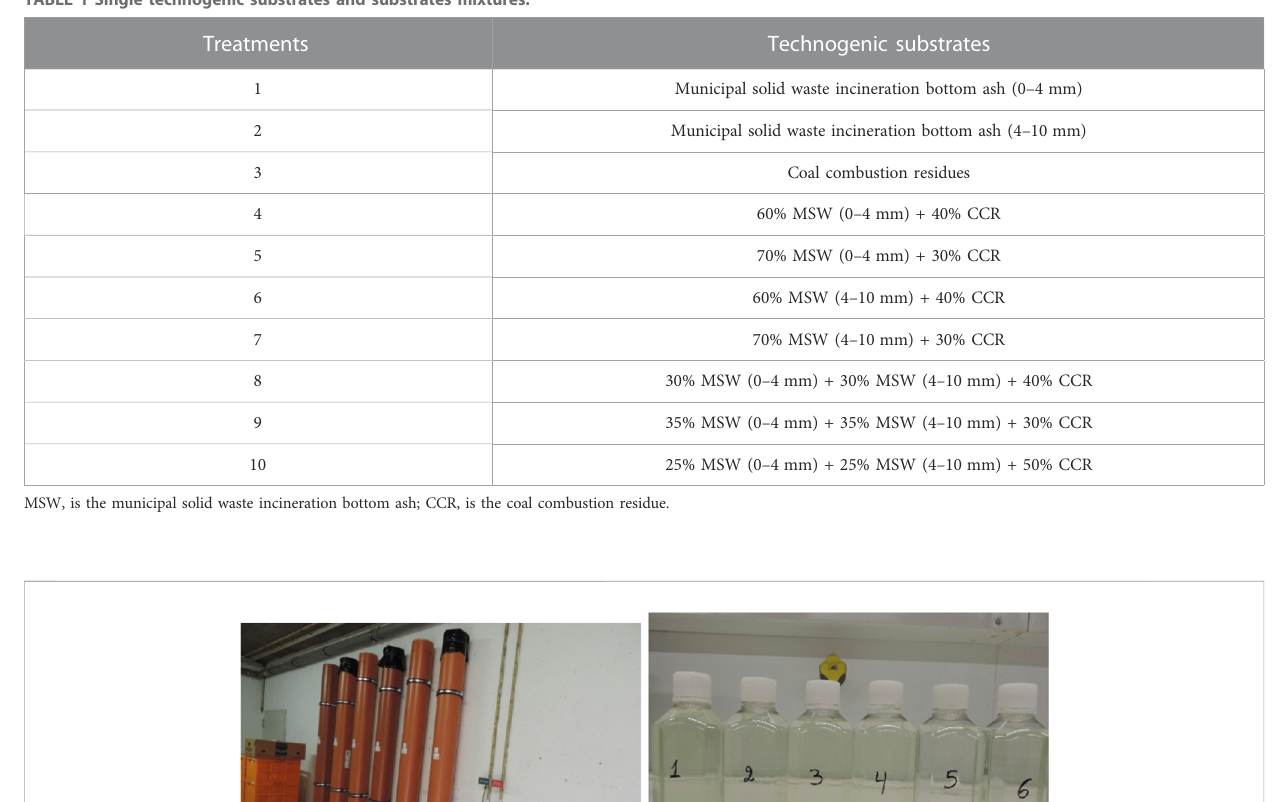
TABLE 1 Single technogenic substrates and substrates